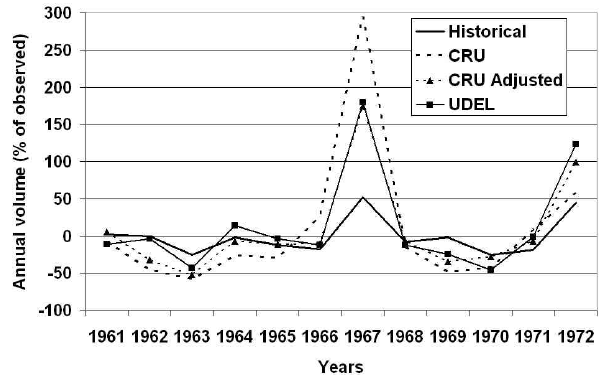
Fig. 6. Deviations (%) from observed of simulated mean annual flow volumes of the Okavango River at Mukwe (using the whole baseline period of 1961 to 1990) based on different input rainfall data. “Historical” data are interpolated local gauges, described in Wilk et al.